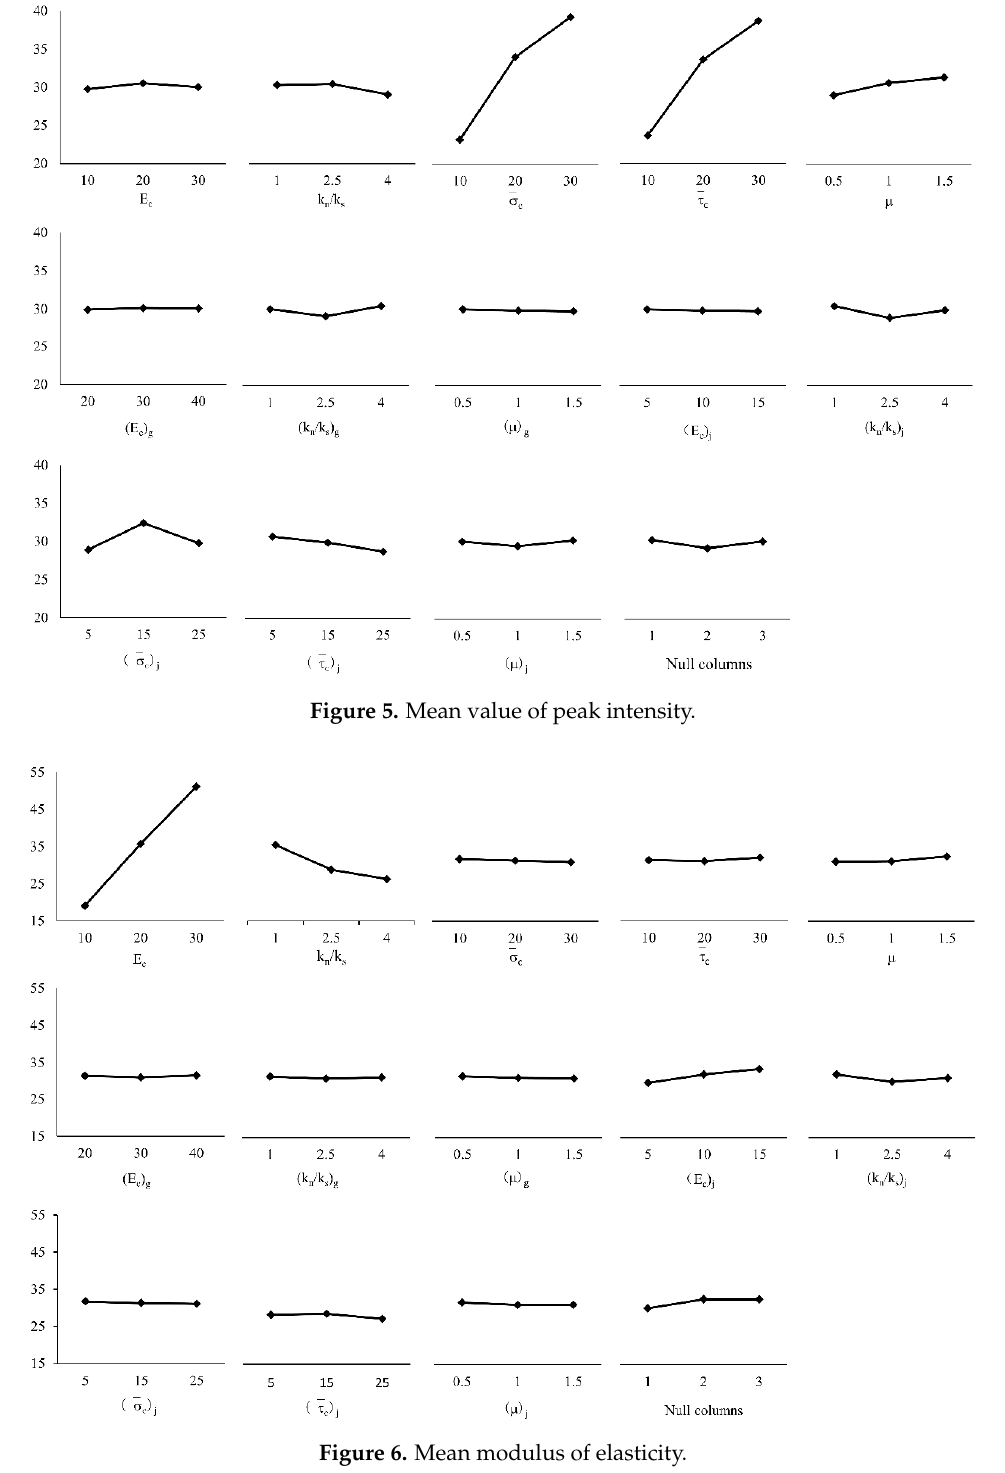
Figure 7. Mean value of Poisson’s ratio.